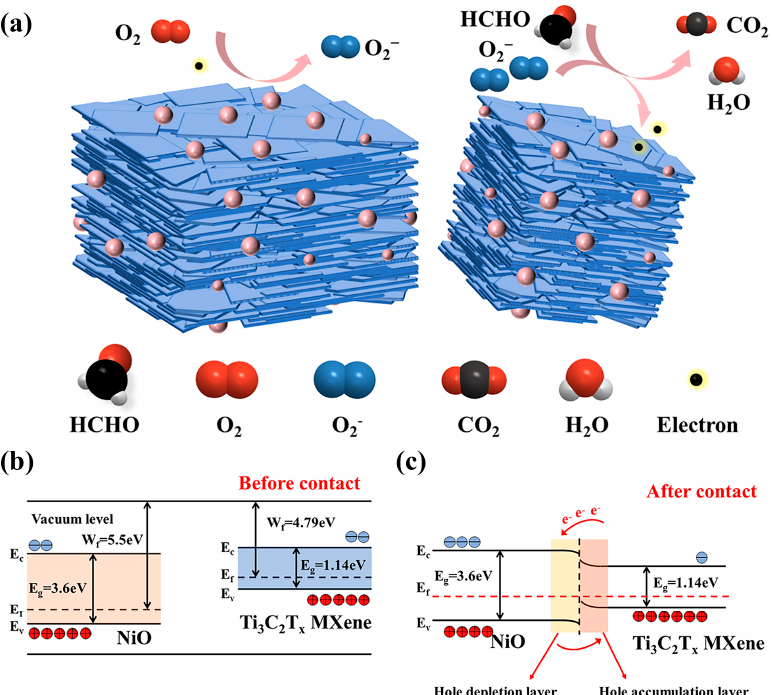
Figure 10. ( a ) Illustration of gas adsorption on the surface of the MXene/NiO material. ( b , c ) Energy band diagram of the MXene/NiO heterojunction before and after contact.